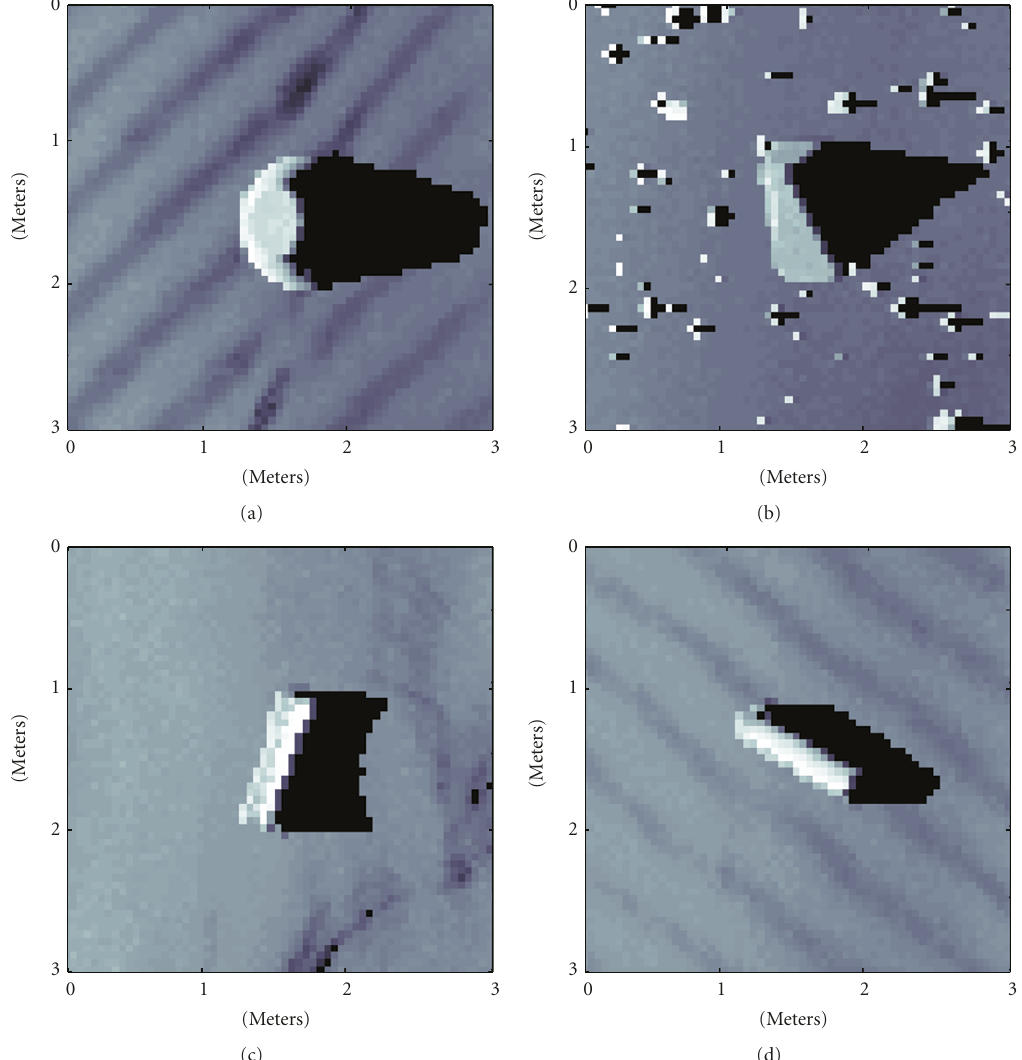
Figure 10: Snapshot of the four targets. (a) Manta, on sand ripples, (b) Rockan on cluttered environment, (c) Cuboid on flat seabed, (d) Cylinder on sand ripples. The pixel size in these targets images is